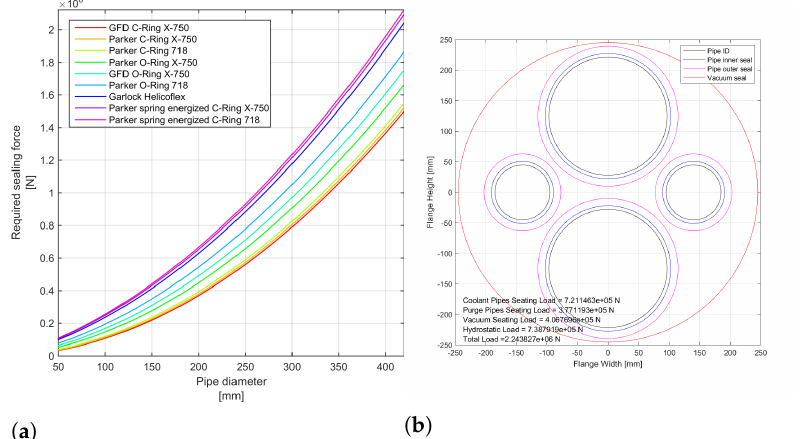
Figure 3. Aspects of sealing design for the MPCs. ( a ) Comparison of sealing forces depending on sealing type. ( b ) Sealing layout on circular flange.